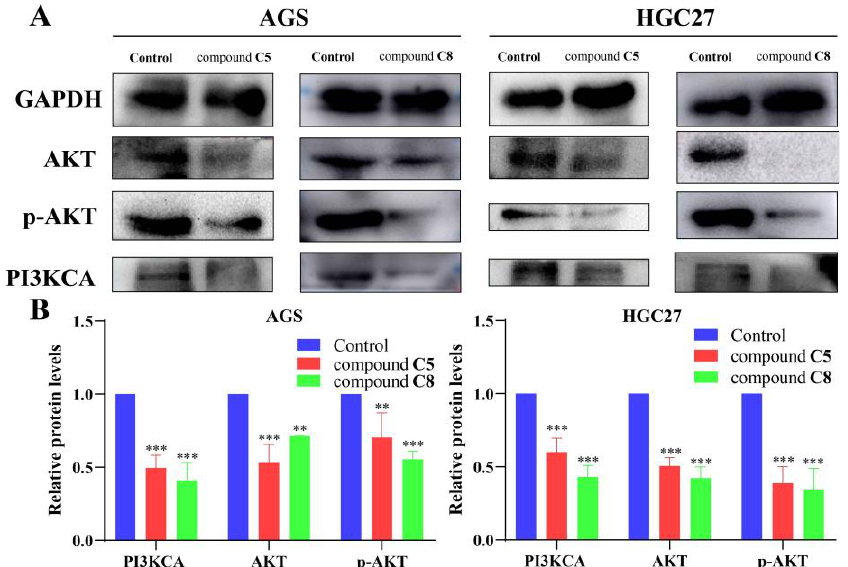
Figure 6. Changes of PI3K/AKT signaling pathway related proteins in AGS and HGC27 cells treated with compounds C5 or C8 for 48 h. ( A ) The expression of PI3KCA, AKT, and p-AKT of AGS or HGC27 cells was inhibited after treatment with compound C5 or C8 for 48 h at 5 μM. ( B ) Changes of PI3KCA, AKT, and p-AKT protein expression levels on AGS and HGC27 cells, after treatment with 5 μM of compounds C5 and C8, for 48 h. * p < 0.05, ** p < 0.01, *** p < 0.001 compared to negative DMSO control group.